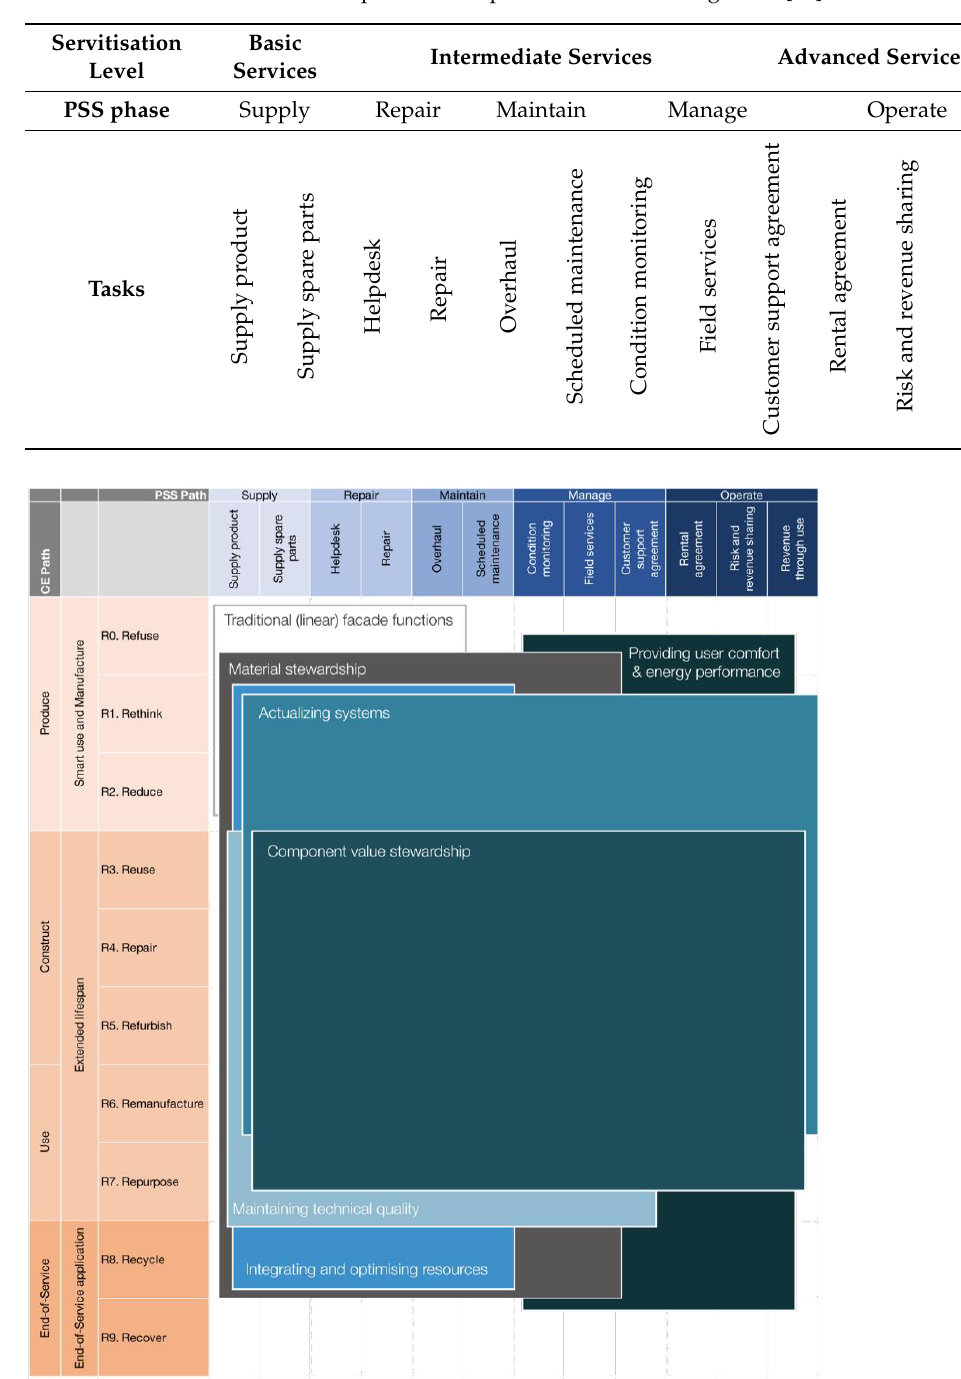
Figure 3. General fields of circular services enabled by a facades-as-a-service model.